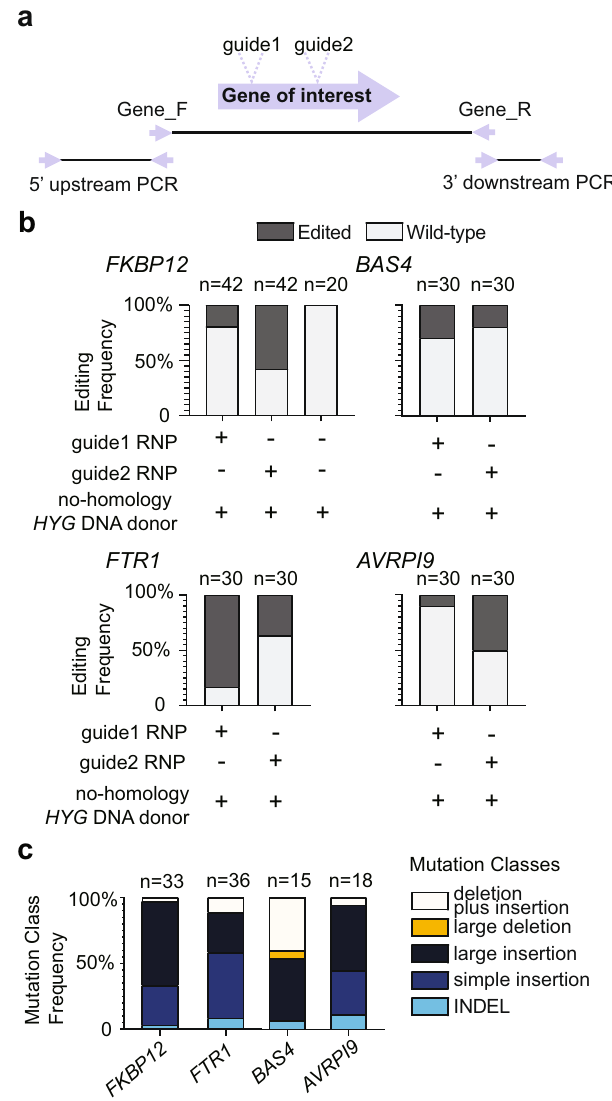
Fig. 4 | DNA repair outcomes following Cas12a editing differ among multiple loci.a SchematicillustrationforCRISPR-Cas12aeditingexperiments.Twodifferent guidesweretestedforeachlocus.Gene_F/Rprimerpairswereusedfora fi rstround of genotyping to determine the type of mutation present in a transformant. PCR negative strains were subsequently genotyped using the 5 ’ upstream and 3 ’ downstream primer pairs per gene to further genotype the occurrence of large- scale DNA alternations. b The editing frequencies at FKBP12 (MGG_06035),